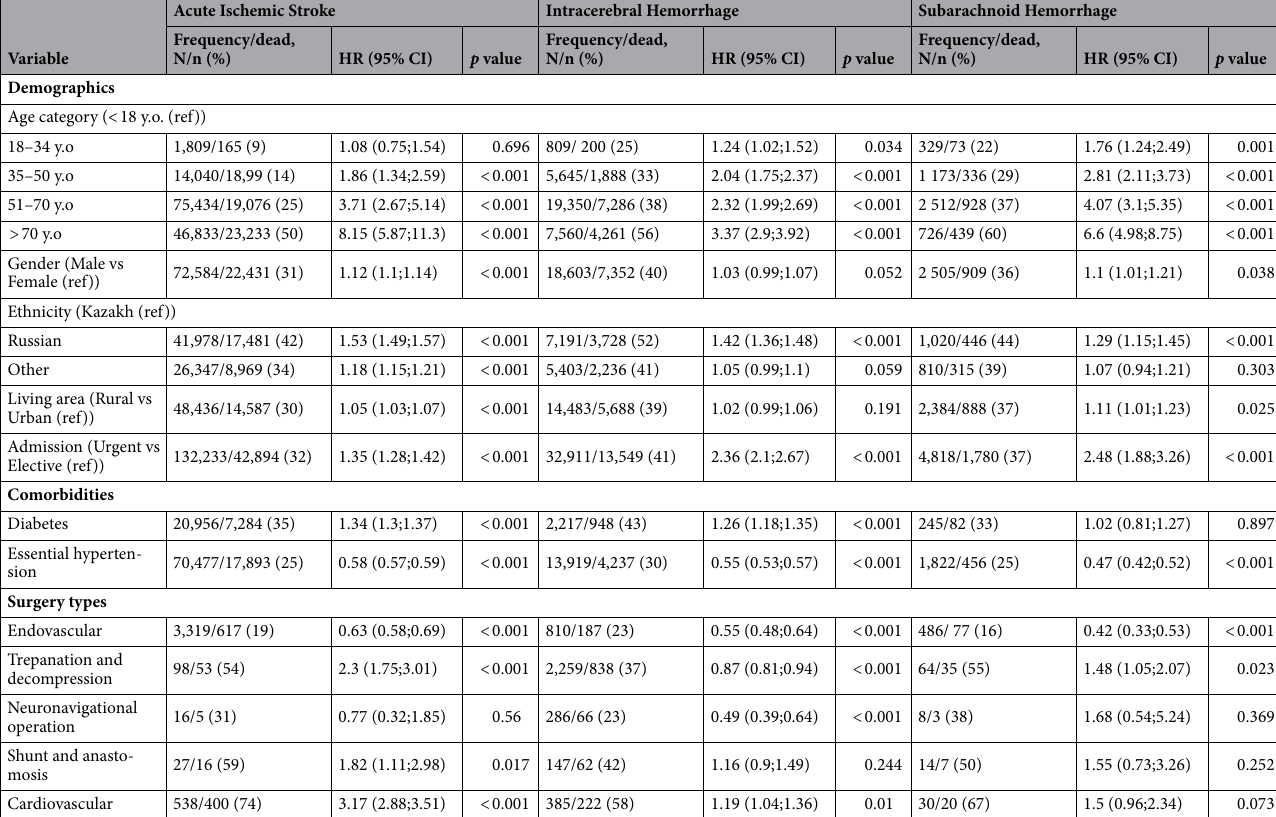
Table 3. Association between socio-demographic and medical parameters and all-cause mortality rates from stroke types for the years